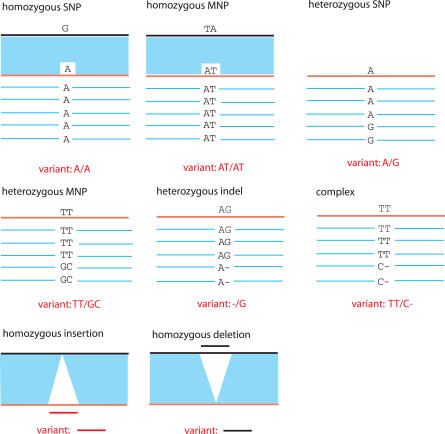
The Different Variant Types Identified from the HuRef Assembly and the HuRef-NCBI Assembly-to-Assembly MappingHuRef consensus sequence (in red) with underlying sequence reads (in blue). Homozygous variants are identified by comparing the HuRef assembly with NCBI reference assembly. Heterozygous variants are identified by base differences between sequence reads. SNP = single nucleotide polymorphism; MNP = multi-nucleotide polymorphism, which contains contiguous mismatches.